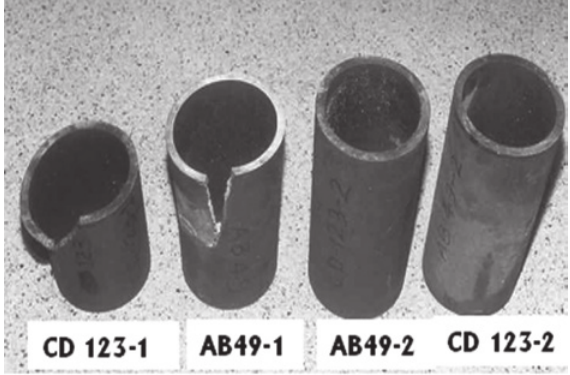
Fig. 10: Photographs of reformer tubes under investigation